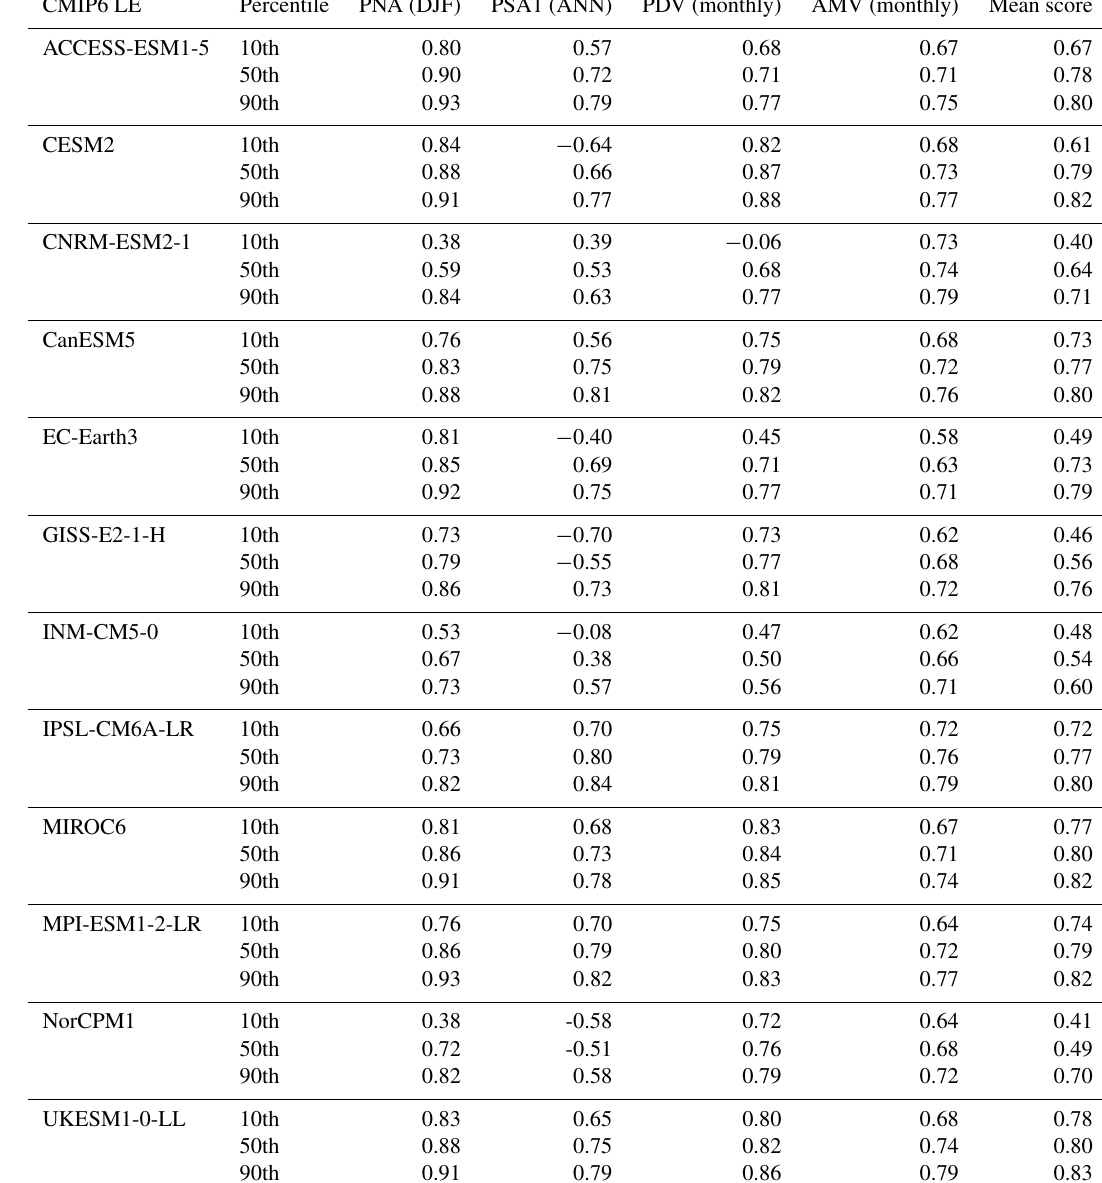
Table A1. Distribution of Pearson r correlation values between the simulated (CMIP6 LE) and observed (ERA20C_ERA5, ERSSTv5) spatial patterns of PNA, PSA1, PDV and AMV and their mean scores over the 1900–2014 period. Sorted in alphabetical order. CMIP6